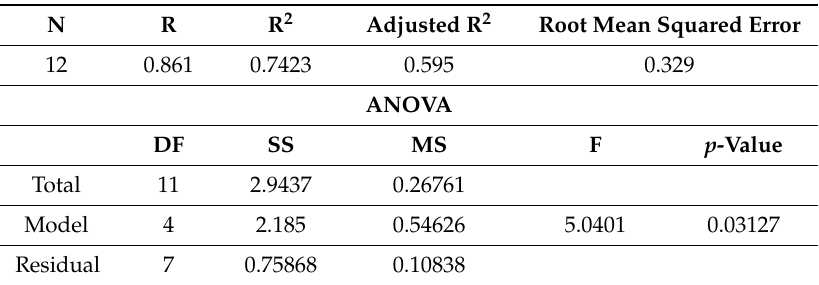
Table 5. Roughness Model Summary.